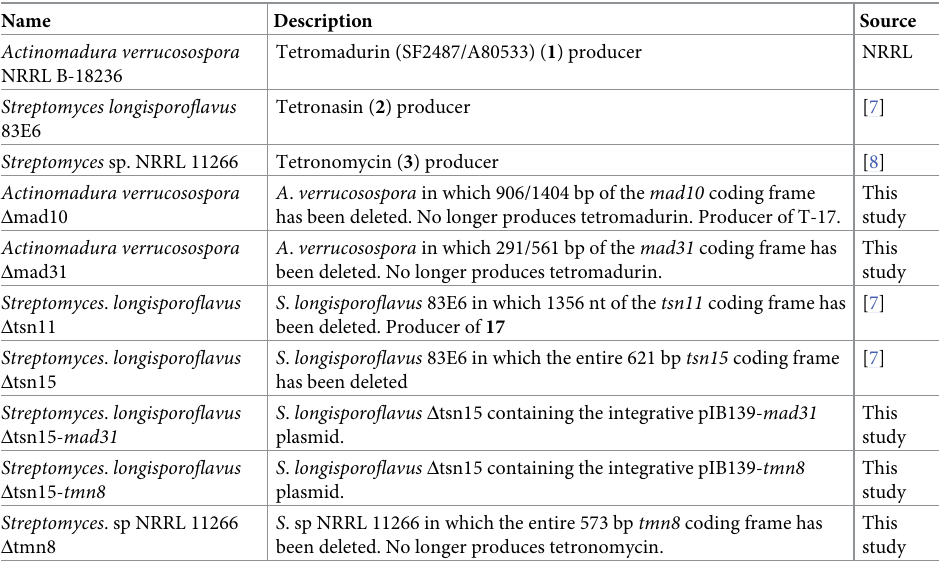
Table 3. Bacteria strains used in this